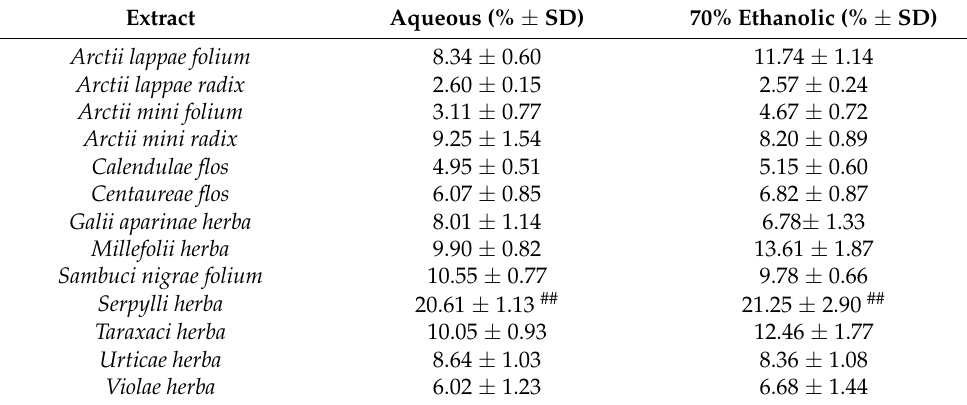
Table 3. Sum of polyphenols determined by the Folin–Ciocalteu method. ## —extracts with the highest content of polyphenols ( p < 0.001).